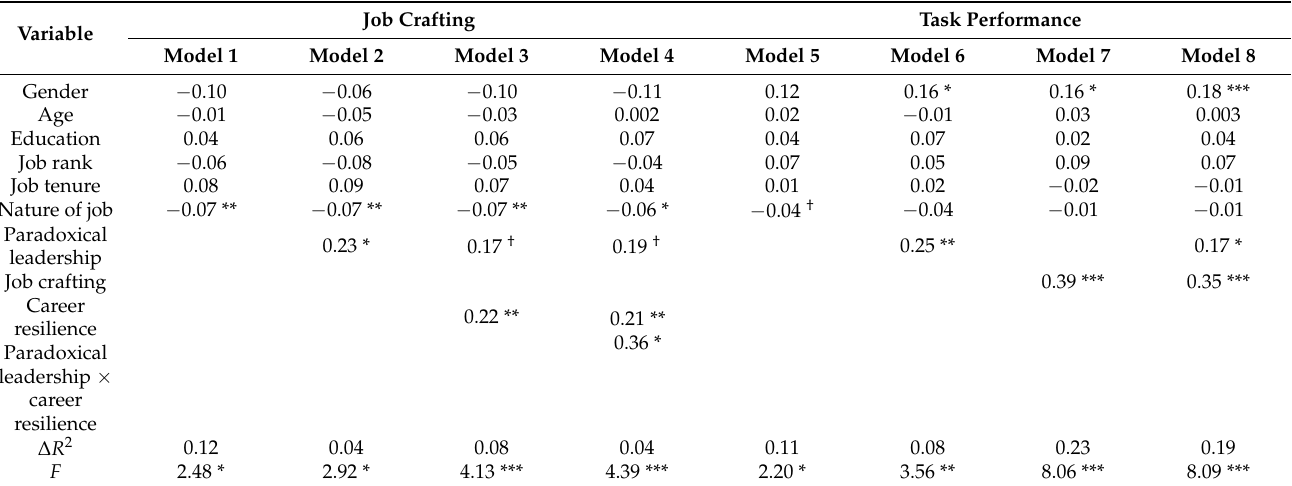
Table 3. Analysis of the mediation and moderating